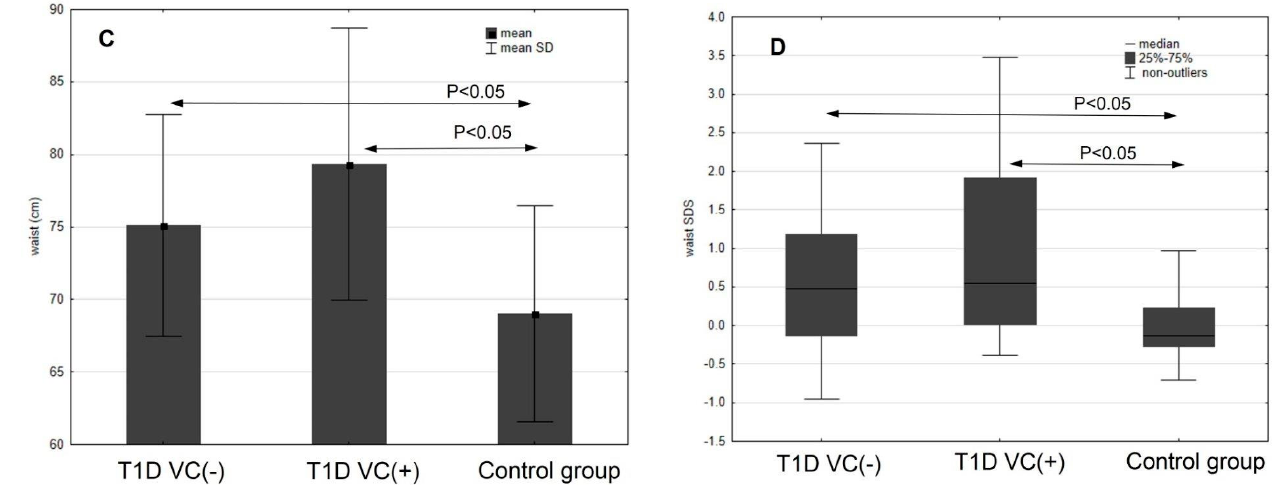
Figure 1. BMI ( A ), SDS-BMI ( B ), waist circumference ( C ) and waist SDS ( D ) in the studied groups. The results of new biomarkers of cardiovascular disease risk showed differences in the myeloperoxidase level (MPO), which was significantly higher in both diabetic groups compared to the healthy controls. More than five times higher levels of hsCRP protein, the highest concentration of NT-proBNP peptide and statistically lower concentration of vitamin D3 were found in the T1D VC (+) group. All patients with diabetes had lower mean vitamin D3 levels compared with controls. There were no statistically significant differences found for adiponectin in the study groups and the control group (Table 2, Fig- ure 2).